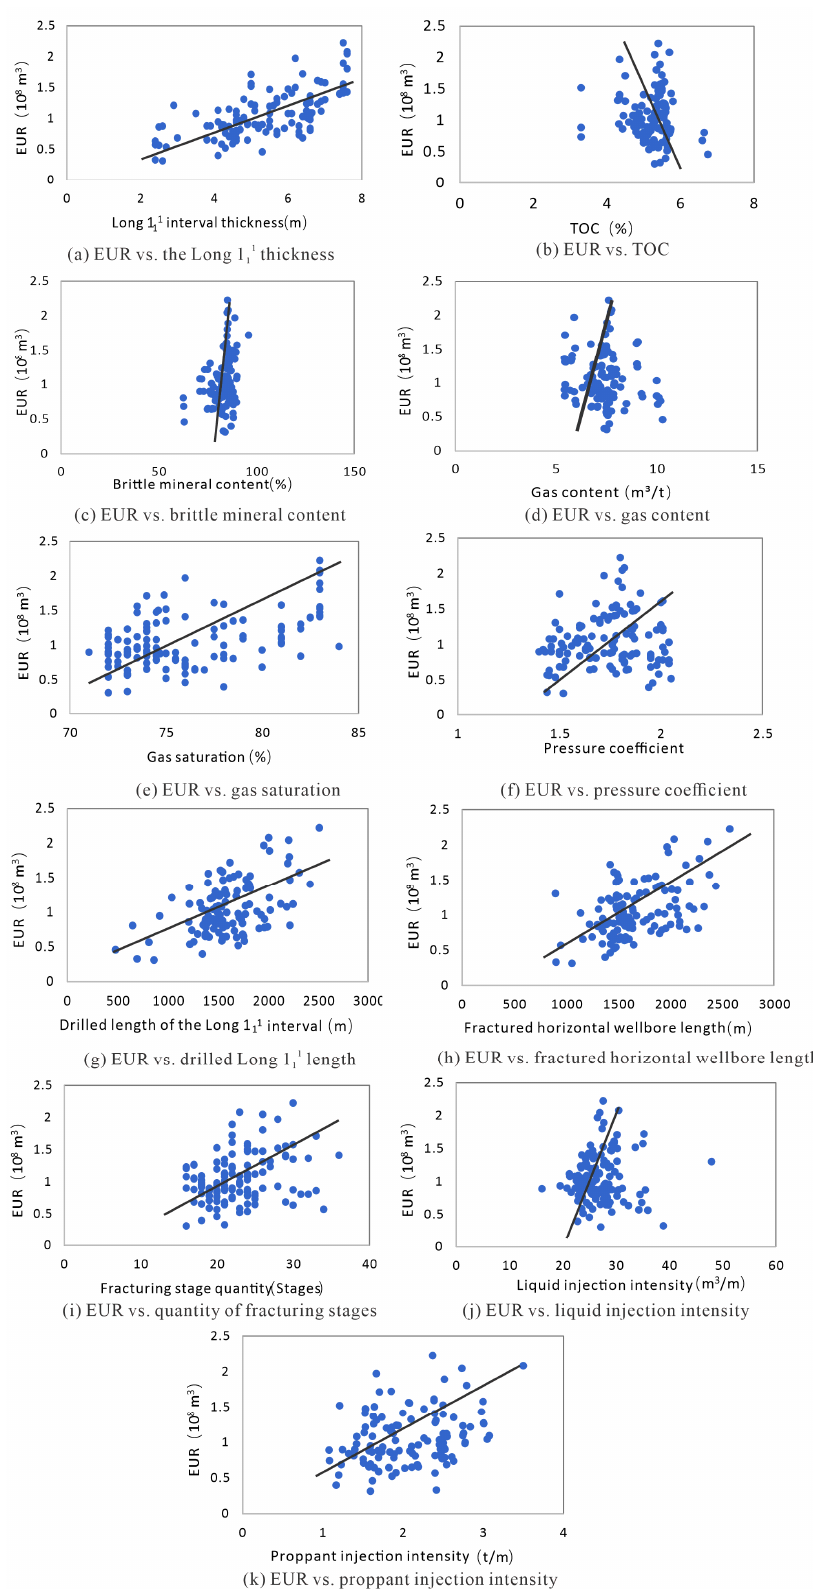
Figure 3. Single-factor regression of factors affecting